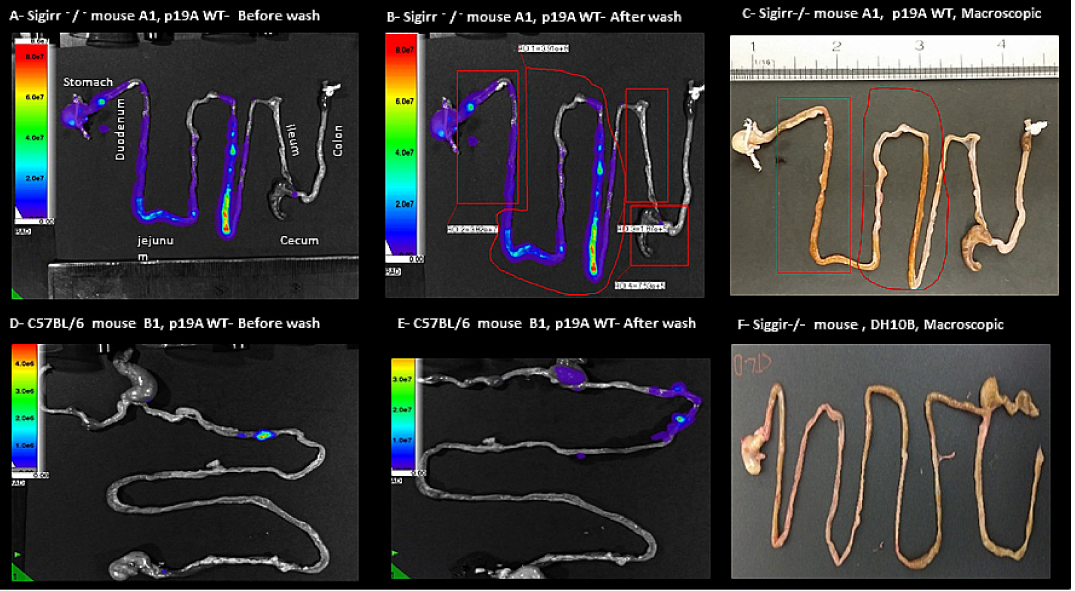
Figure 3. In Vivo Imaging System (IVIS) evaluation of experimental mice. ( A ) p19AWT infected Sigirr − / − mouse on the 3rd day post-infection, expressing 50 × greater luminescent signals from the gastrointestinal-tract before washing ( B ) and after washing in phosphate-bu ff ered saline (PBS). ( C ) Macroscopic picture of the gastrointestinal tract of the same mouse from Figure 3A, showing the area of inflammation as thickened, swollen tissues marked with red. ( D ) p19A WT infected C57BL / 6 mouse on the 4th day post-infection, expressing luminescent signals from the colon, cecum and ileum before washing ( E ) and after washing in PBS. ( F ) Macroscopic picture of the gastrointestinal tract of a DH10B infected mouse, showing no signs of inflammation or thickened or swollen